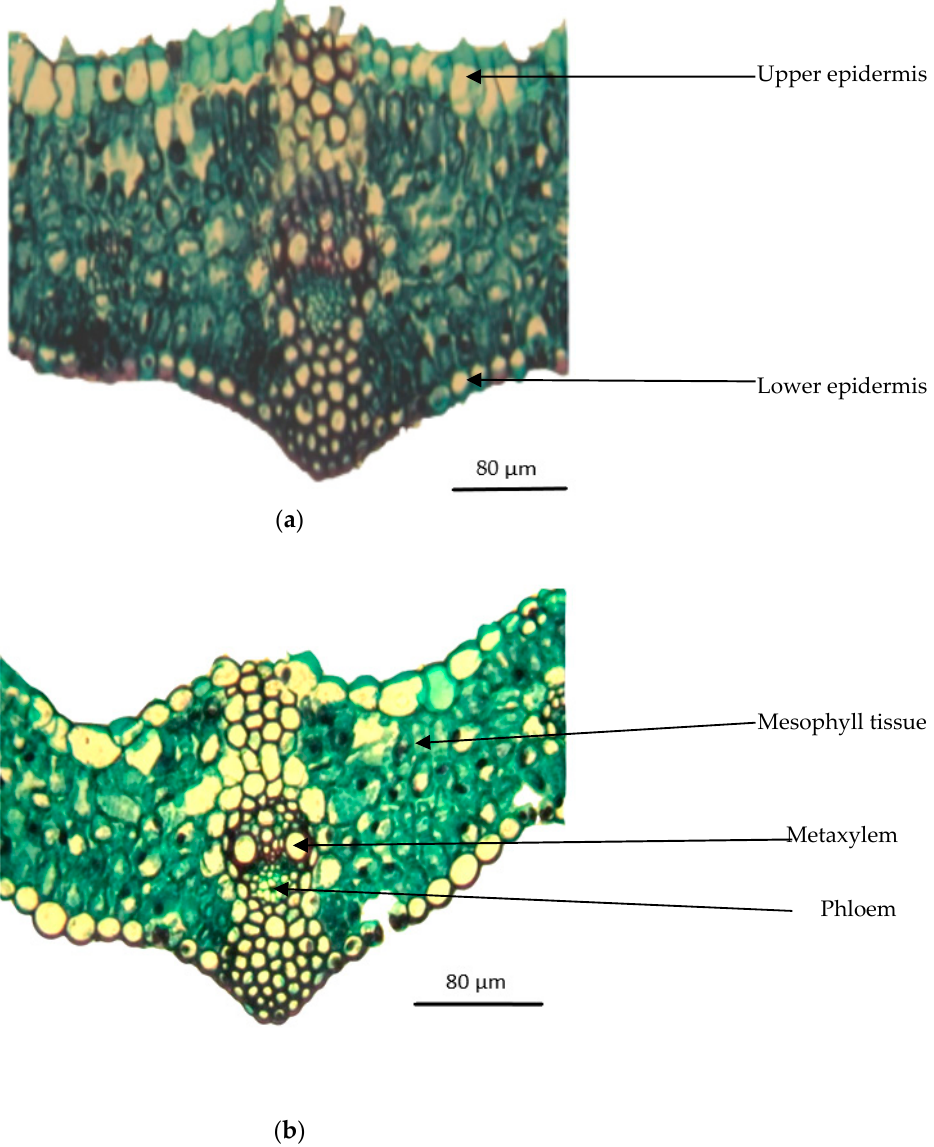
Figure 5. Transverse sections through the median portion of lamina of a leaf developed at the median portion of the main stem of wheat plants grown for 56 days at 0.23 and 6.0 dS m − 1 salt stress. ( × 330). ( a ) (0.23 dS m − 1 ); ( b ) (6.0 dS m − 1 ).